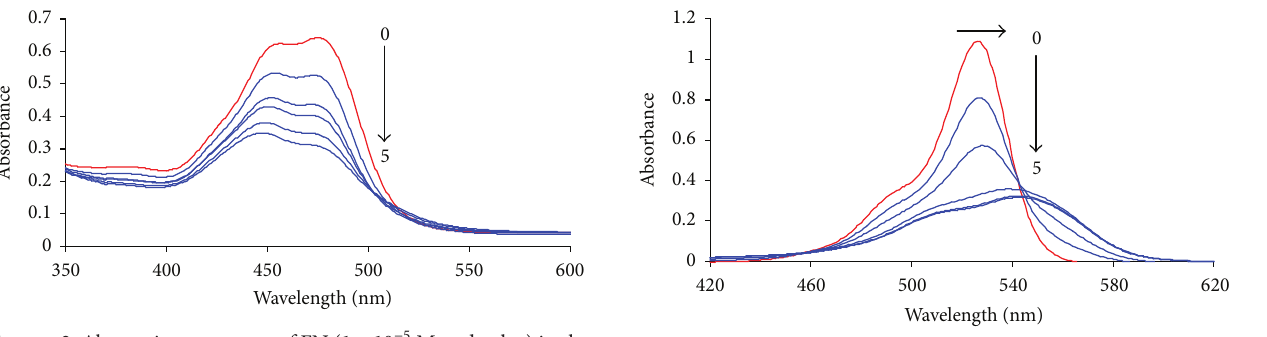
Figure 4: Absorption spectrum of ERN ( 1 × 10 −5 M; red color) in the presence of colloidal SnO 2 ( 0 – 5 × 10 −4 M; blue color) in water.The arrow indicates the absorbance decreases with red shift on increasing concentration of colloidal SnO 2 .